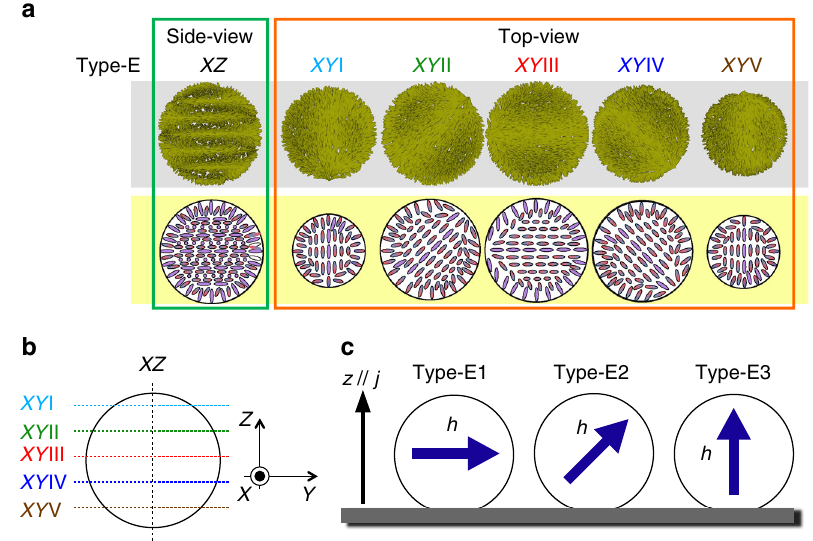
Fig. 9 Models of director fi elds for Type-E. a Schematics of the director models of Type-E. See the caption of Fig. 8 for explanations of the drawings. The trial functions, Supplementary Equations (7) and (8), are used for the numerical depiction of the director, with the sample coordinates ( X,Y,Z ) introduced by setting the z -axis along the helical axis h . Six cross-sectional positions ( XZ , and XY I – XY V) are chosen according to the schematic ( b ). Note that XY III corresponds to the equatorial plane ( = midplane). c Geometrical con fi guration of the helical structure embedded in the droplets attached on the substrate. According to the simulated polarised micrographs, by using this director fi eld for Type-E (Fig. 1l – n), it was concluded that the difference among the three types of Type-E was attributed to the directional difference of the helical axis h with respect to the substrate normal. Note that the z -axis in c corresponds to the cell normal, which is parallel to the temperature gradient and, hence, the heat fl ux